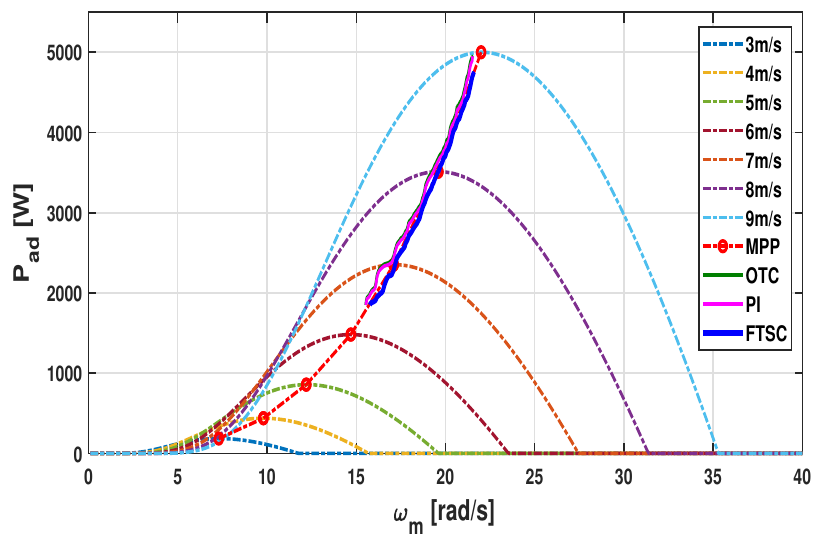
Figure 17. MPP trajectory tracking performance comparison for varying wind profile case-I